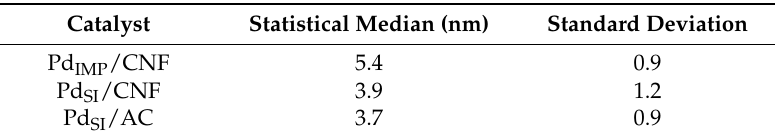
Figure 3. Bright field transmission electron microscopy (TEM) micrographs and corresponding histograms of the particle size distributions for the catalysts: Pd IMP /CNF ( A , B ); Pd SI /CNF ( C , D ); and Pd SI /AC ( E , F ). Table 2. Statistical mean and standard deviation of particle size analysis.